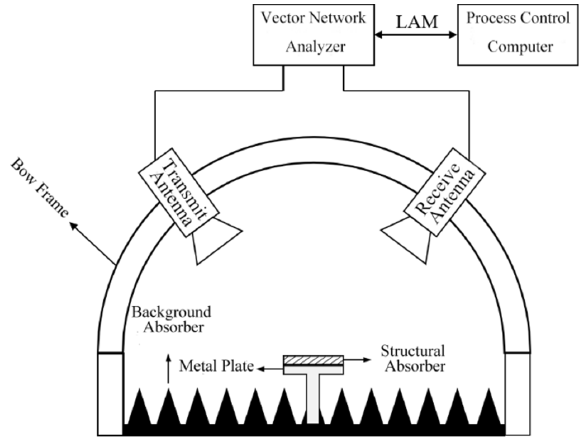
Figure 3. Schematic of arc reflection test